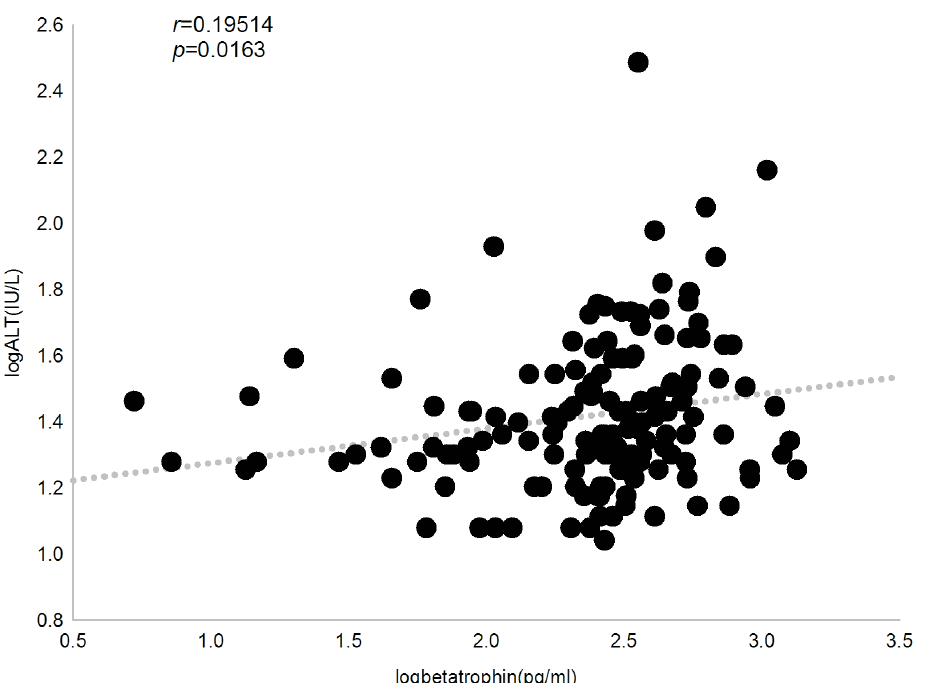
Fig 5. Correlation between plasma betatrophin concentration and alanine aminotransferase level. Betatrophin level positively correlates with alanine aminotransferase level in all subjects ( r = 0.195, P =